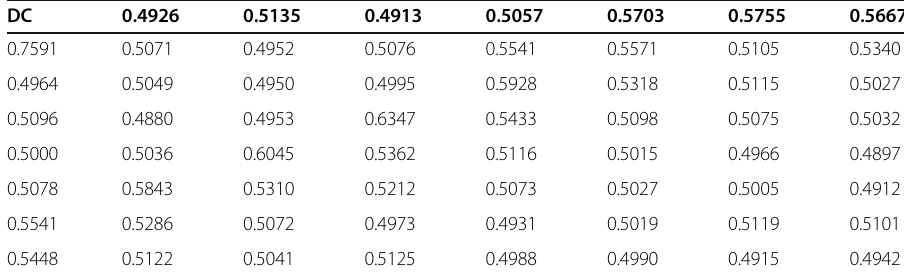
Table 2 Location accuracy for co-frequency sub-images with the individual corresponding first- order Markov model DC